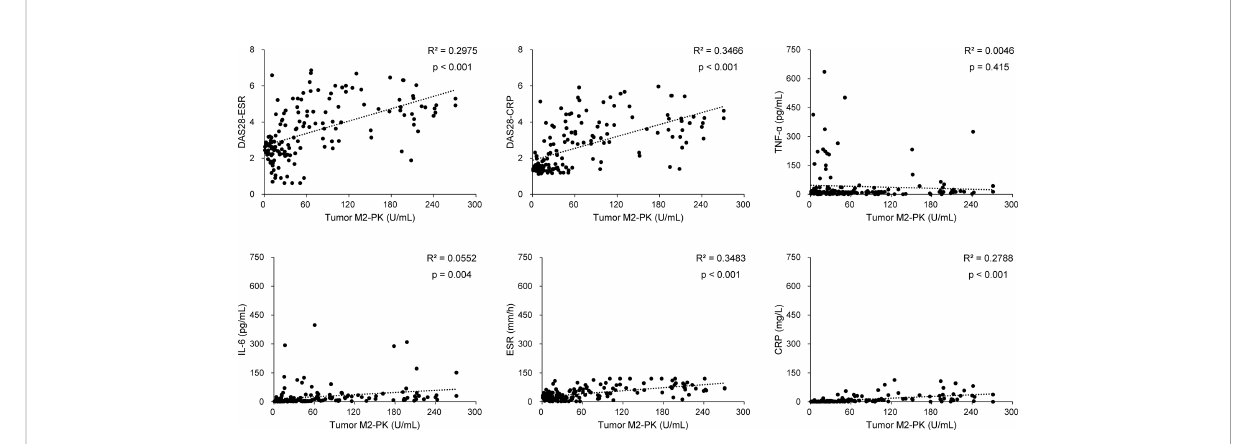
FIGURE 1 Correlation between tumour M2-PK level and disease activity, TNF- a , IL-6, ESR, and CRP level. Tumour M2-PK levels signi fi cantly correlated with disease activity and laboratory results of IL-6, ESR, and CRP, but did not show a correlation with TNF- a . Pearson ’ s correlation analysis was performed to elucidate the relationship between tumour M2-PK levels and continuous variables. Tumour M2-PK, dimeric form of pyruvate kinase M2; TNF, tumour necrosis factor; IL, interleukin; ESR, erythrocyte sedimentation rate; CRP, C-reactive protein; DAS28: disease activity score in 28 joints.